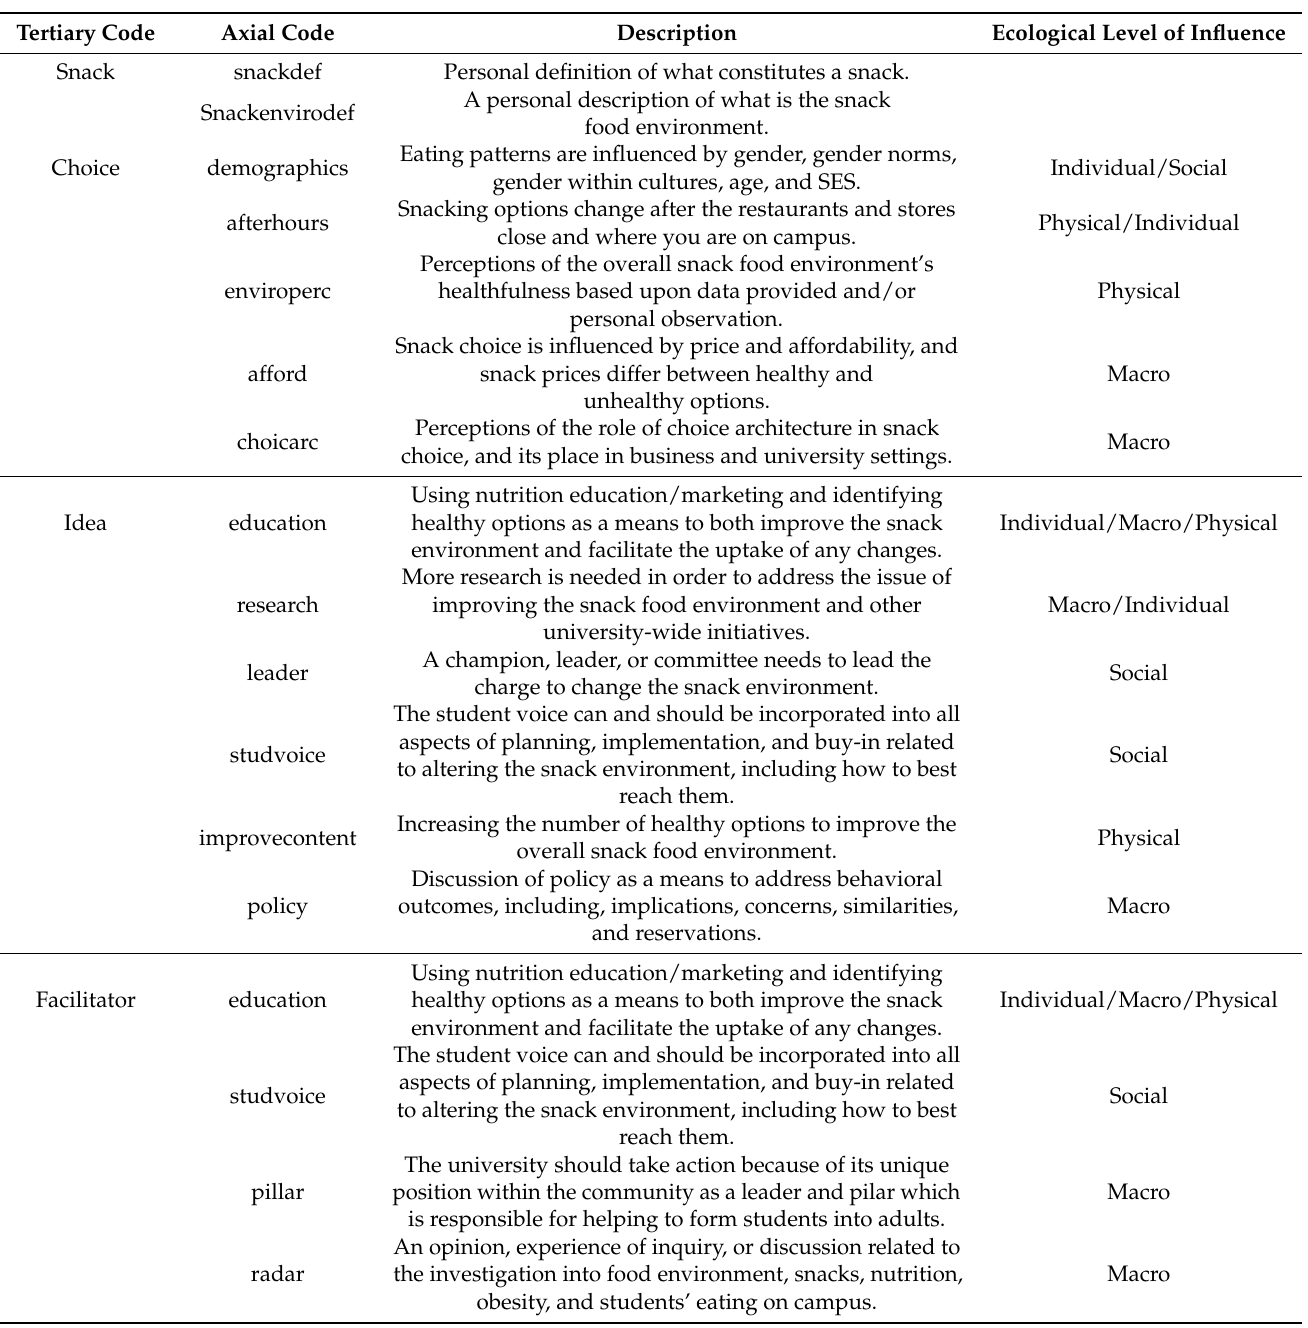
Table 1. Axial and tertiary codes and